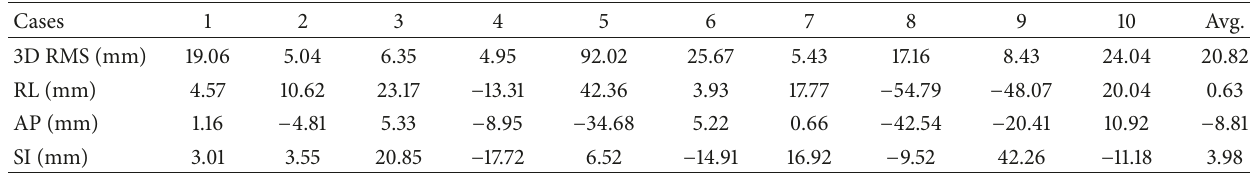
Table 1: The root-mean-square error of fiducial registration with regard to the 3D average distance and the average displacement of landmark feature points in the following three directions before DIR in the 10 cases: right-left (RL), anterior-posterior (AP), and superior-inferior (SI).